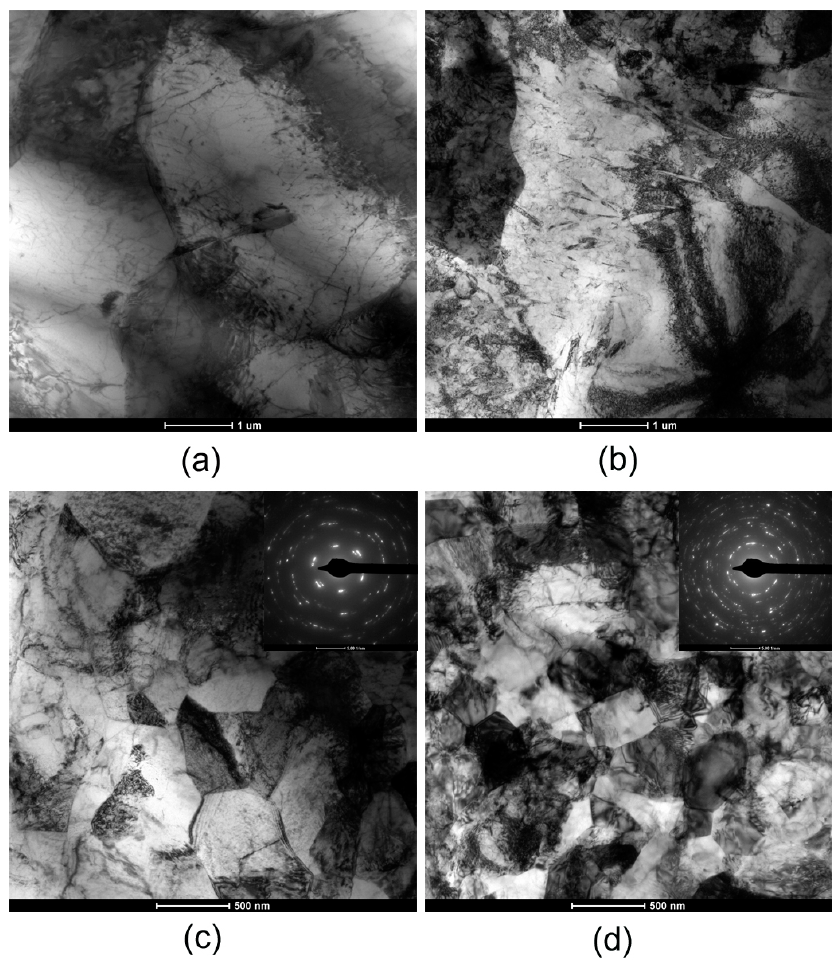
Figure 2. TEM micrographs and SAED patterns of pure Ti processed by RD-ECAP for: ( a ) zero passes; ( b ) two passes; ( c ) three passes; ( d ) four passes.